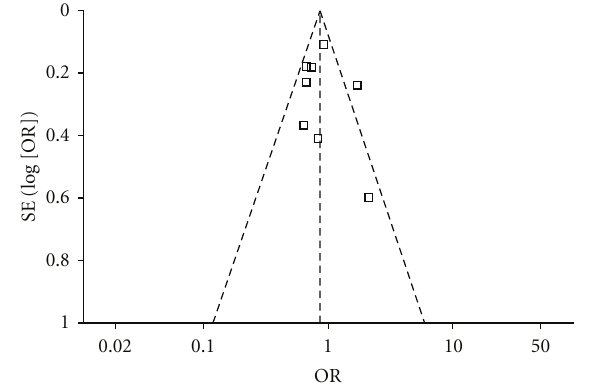
Figure 5: Funnel plot of tea drinking and the risk of PD. The log OR from each study is plotted on the horizontal axis, and its standard error is plotted on the vertical